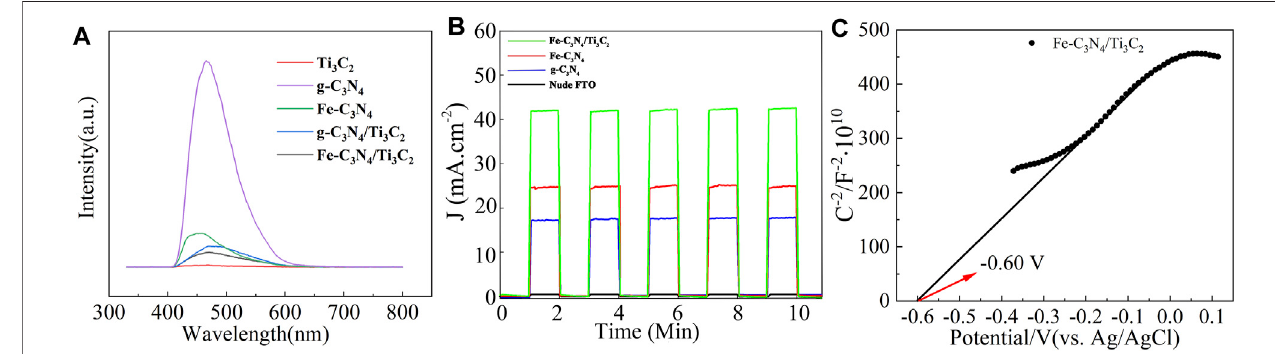
FIGURE 6 | (A) PL spectra of g-C 3 N 4 , Ti 3 C 2 , Fe-C 3 N 4 , g-C 3 N 4 /Ti 3 C 2, and Fe-C 3 N 4 /Ti 3 C 2. (B) The transient photocurrent density of nude FTO, g-C 3 N 4 , Fe-C 3 N 4 and